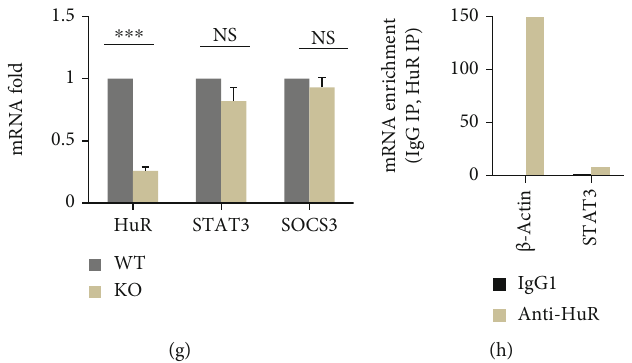
Figure 3: Genetic deletion of HuR reduces the activities of STAT-3 in Th17 cells. (a) Naïve CD4 + T cells were stimulated under Th17 cell polarization condition for 4-5 days. The levels of cytokine mRNAs were measured by RT-qPCR. (b) Flow cytometry assay showed that percentage of IL-17A-positive cells signi fi cantly decreased, but that of IL-17F-positive cells slightly decreased. (c) Summary of fl ow data for Th17 cell culture from three independent experiments ( mean ± SEM ). (d) WT and HuR KO Th17 cells were cultured under Th17 cell culture condition with anti-IL-2 (30 μ g/ml) for 5 days. Representative fl ow cytometric data was shown. (e) Summary of fl ow data for Th17 cell culture with or without anti-IL-2 from three independent experiments ( mean ± SEM ). (f) Th17 cells were rested 2 days in the presence of IL-2 (3 ng/ml) following restimulation in the presence of Th17 cell-polarizing cytokines (TGF- β +IL-6) without IL-23 for the indicated times. Western blot assay showed that HuR de fi ciency in Th17 cells reduced the level of p-STAT3 compared to WT Th17 cells, but not total STAT-3. (g) Knockout of HuR did not reduce the level of Stat3 and SOCS3 mRNA in Th17 cells as characterized by RT- qPCR. (h) RIP assay indicated that HuR did not bind to Stat3 mRNA. Data in (a), (c), (e), and (g) represents the summary of three independent experiments. Student ’ s t -test was used for statistics analysis. ∗ p < 0 : 05 , ∗∗ p < 0 : 01 , and ∗∗∗ p < 0 : 001 . Data in (b), (d), (f), and (h) represent one of the three independent